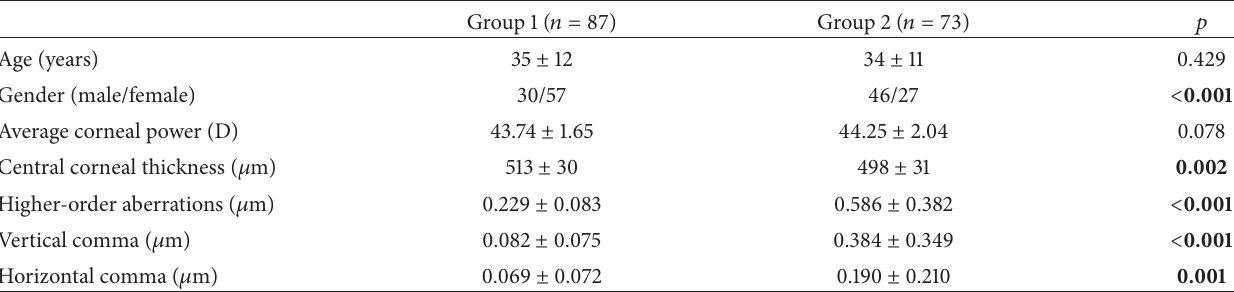
Table 1: Demographics and corneal characteristics of control and keratoconic eyes. Demographics and corneal characteristics of control (group 1) and subclinical keratoconus (group 2) eyes. Data is expressed as mean ± standard deviation.